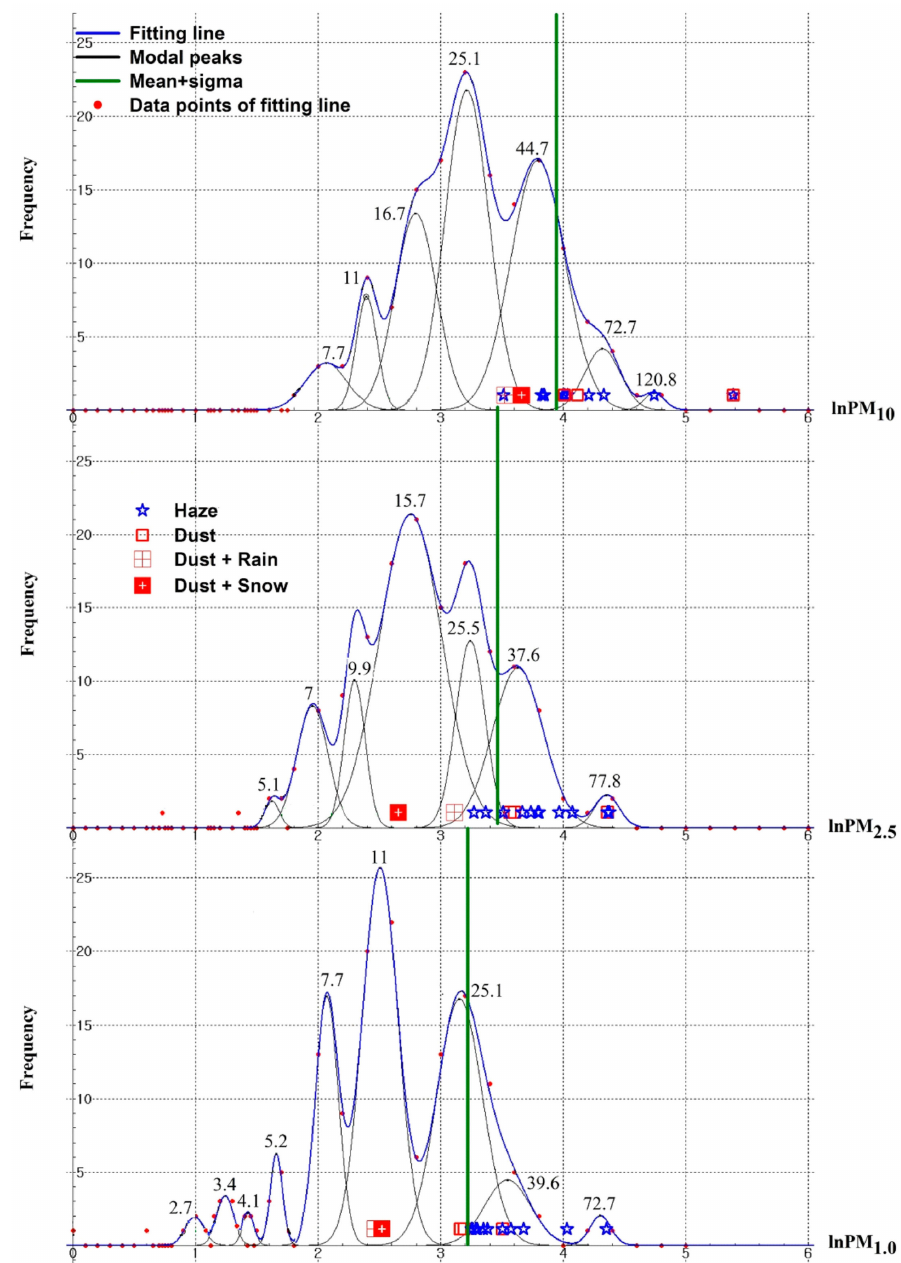
Figure 5. Frequency distributions of PM 10 , PM 2.5 and PM 1 mass concentrations for the measurements during August 2007–February 2012. Mass concentrations are given as ln values in x-axis. The green lines stand for mean + SD. The individual samples collected during dust or haze events are marked as different symbols along the x-axis. Dust + Rain and Dust + Snow mean that the events happened together, where rain and snow were as recorded by the